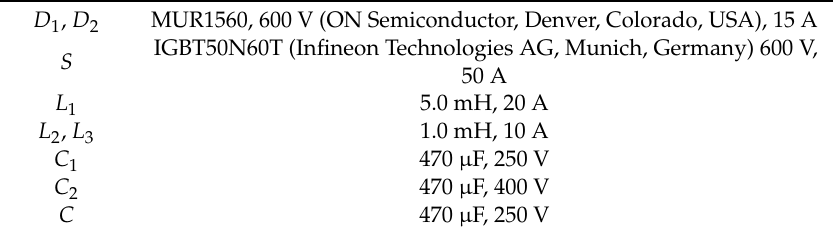
Table 4. DC-DC combined converter components.